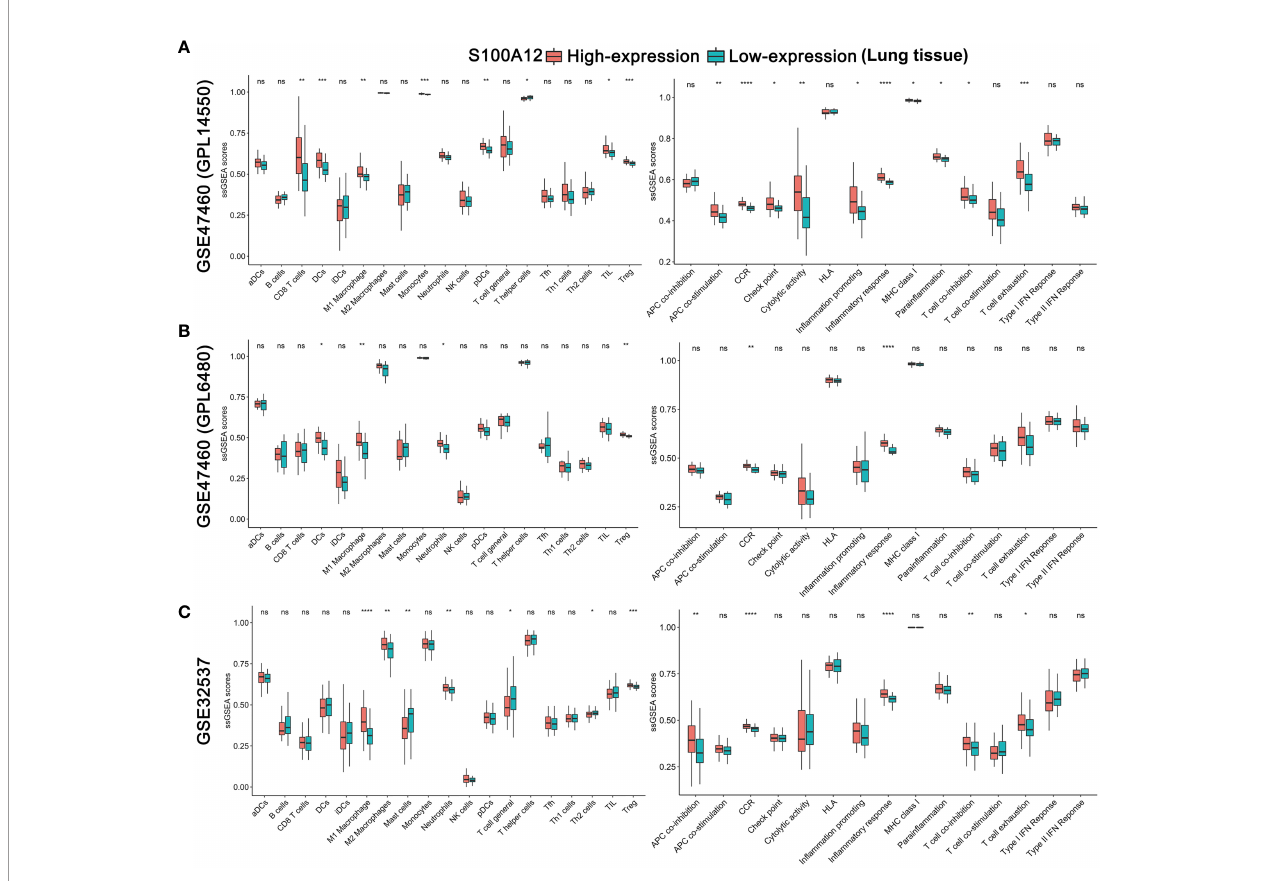
FIGURE 7 | Comparison of the lung ssGSEA scores between patients with high-expression and low-expression S100A12 in the GSE47460 (GPL14550) (A) , GSE47460 (GPL6480) (B) , and GSE32537 datasets (C) . The scores of 19 immune cells are displayed in the left side, and 15 immune-related functions are displayed in the right side. DC, Dendritic Cell; TIL, Tumor in fi ltrates lymphocytes; CCR, cytokine-cytokine receptor. P-values were showed as: ns, not signi fi cant; *P < 0.05; **P < 0.01; ***P < 0.001; ****P <